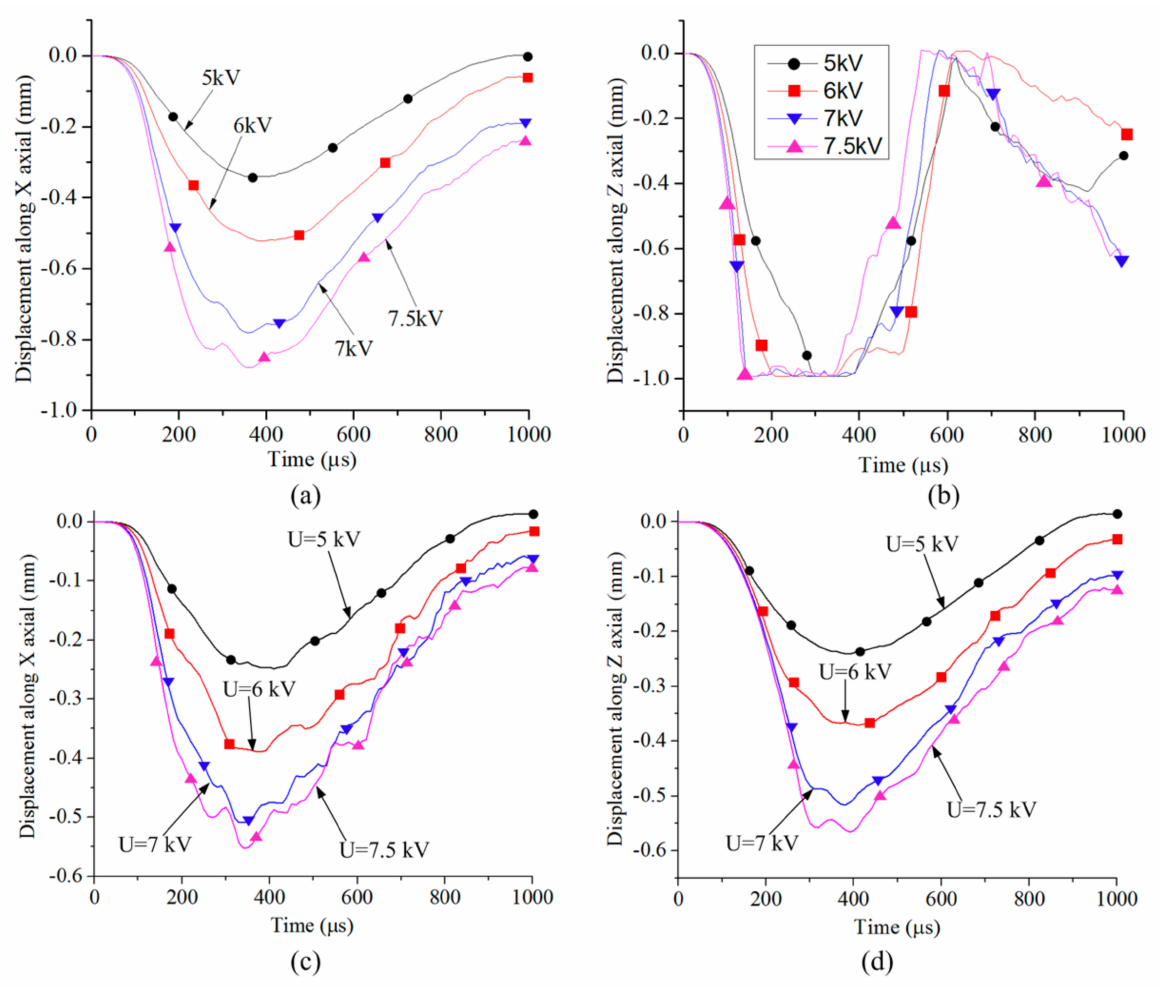
Figure 13. Displacement vs. time along ( a ) the X-axis at node 3067, ( b ) the Z-axis at node 3067, ( c ) the X-axis at node 6985, and ( d ) the Z-axis at node